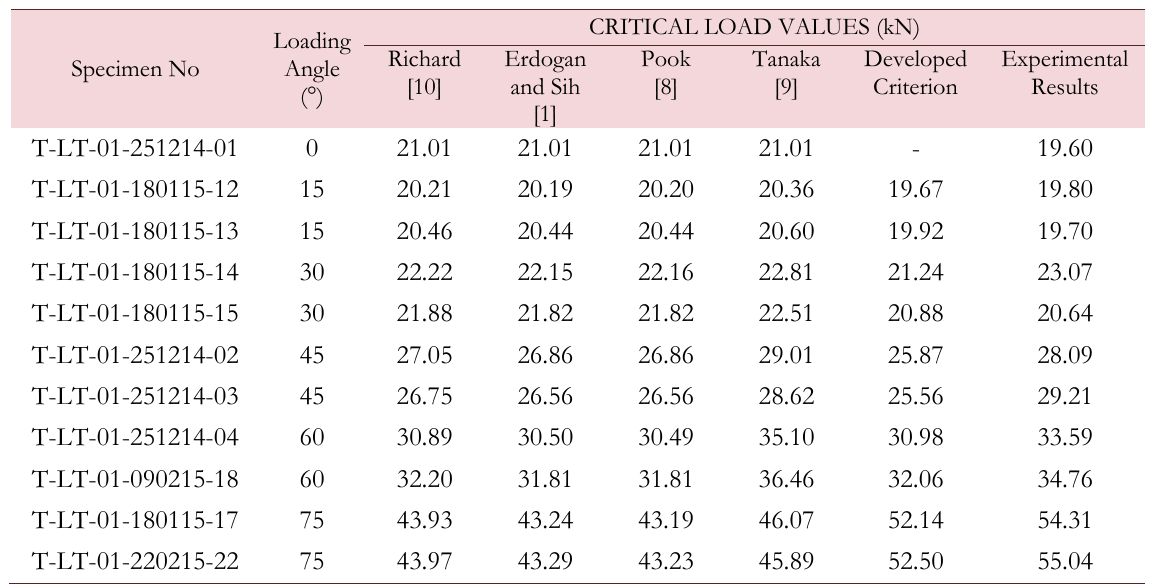
Table 5: Experimental and predicted T-specimen fracture loads obtained from the developed criterion along with other existing criteria in the literature.